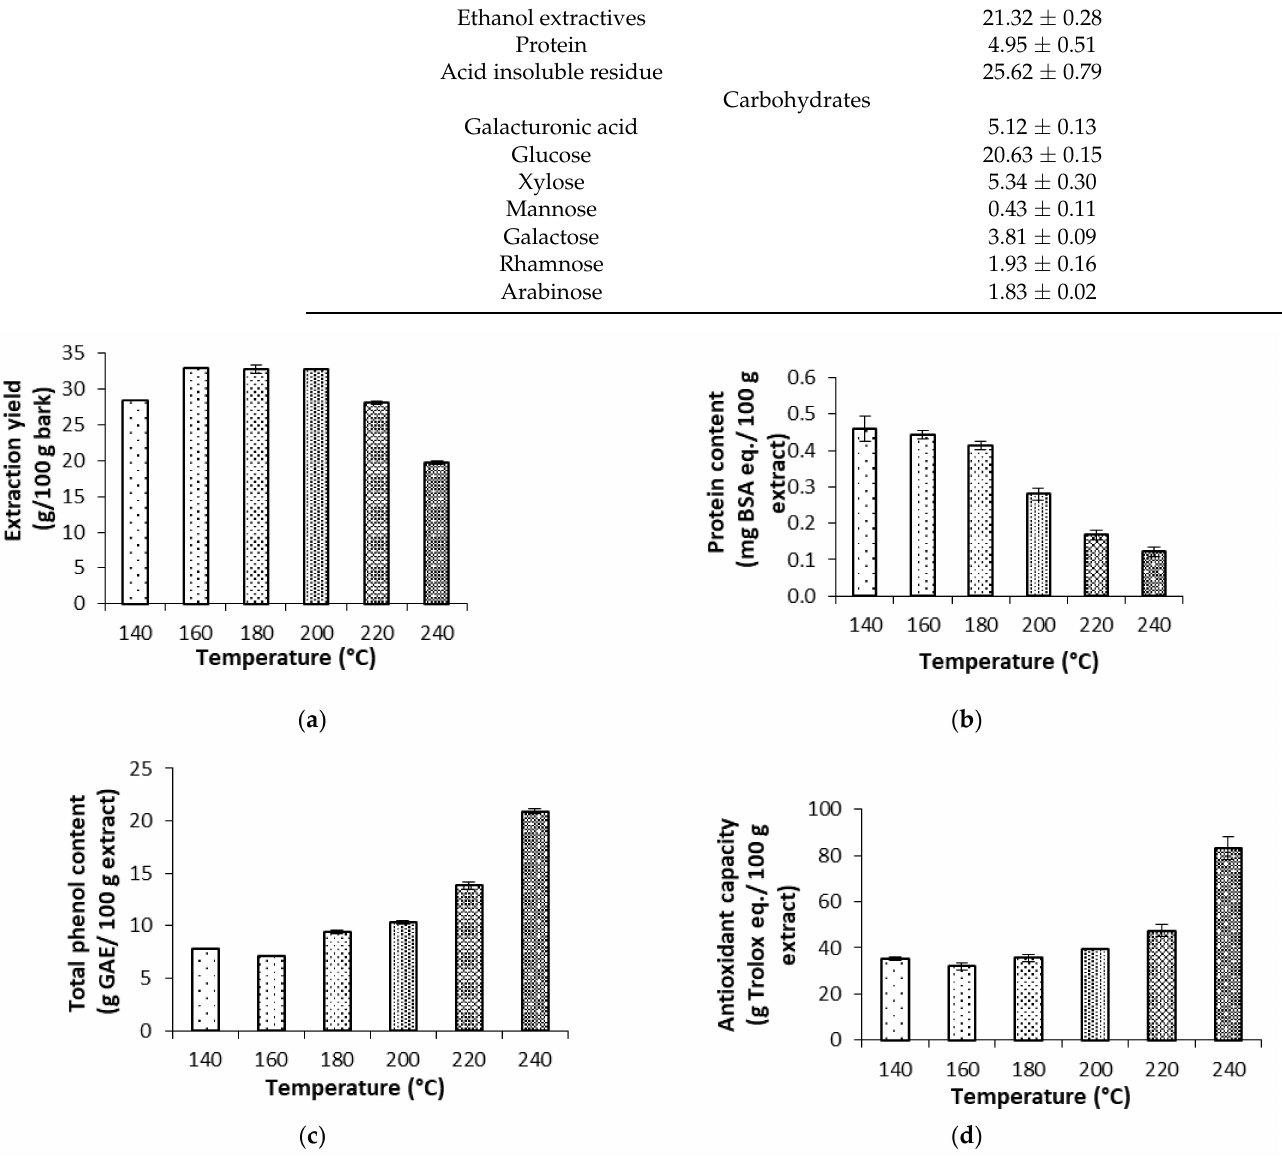
Figure 1. Influence of the final subcritical water extraction temperature on total extraction yield ( a ), protein content ( b ), the total phenolic content ( c ) and the antiradical capacity against ABTS (2,2 (cid:48) -azino-bis-(3-ethylbenzothiazoline-6-sulfonic acid)), ( d ), for the aqueous extracts from bark. According to data from Table 2, the saccharidic fraction was mostly found as oligomers, with glucose, arabinose and galactose as the most abundant. The operation temperature affected the different compounds differently; glucose in oligomeric units decreased with temperature, and the monomers only decreased at the highest values; galactose remained in oligomers up to 200 ◦ C, but the monomer concentration decreased with temperature; and both xylose and arabinose content in oligomeric form increased with temperature, but the monomers were less affected. As expected, the organic acid concentration increased with operation temperature. Maximal extraction yields of 30% in the range of 160–200 ◦ C were attained in subcritical water extraction, and at higher treatment temperatures, decreased values were observed until 20%. However, the phenolic content of the extracts